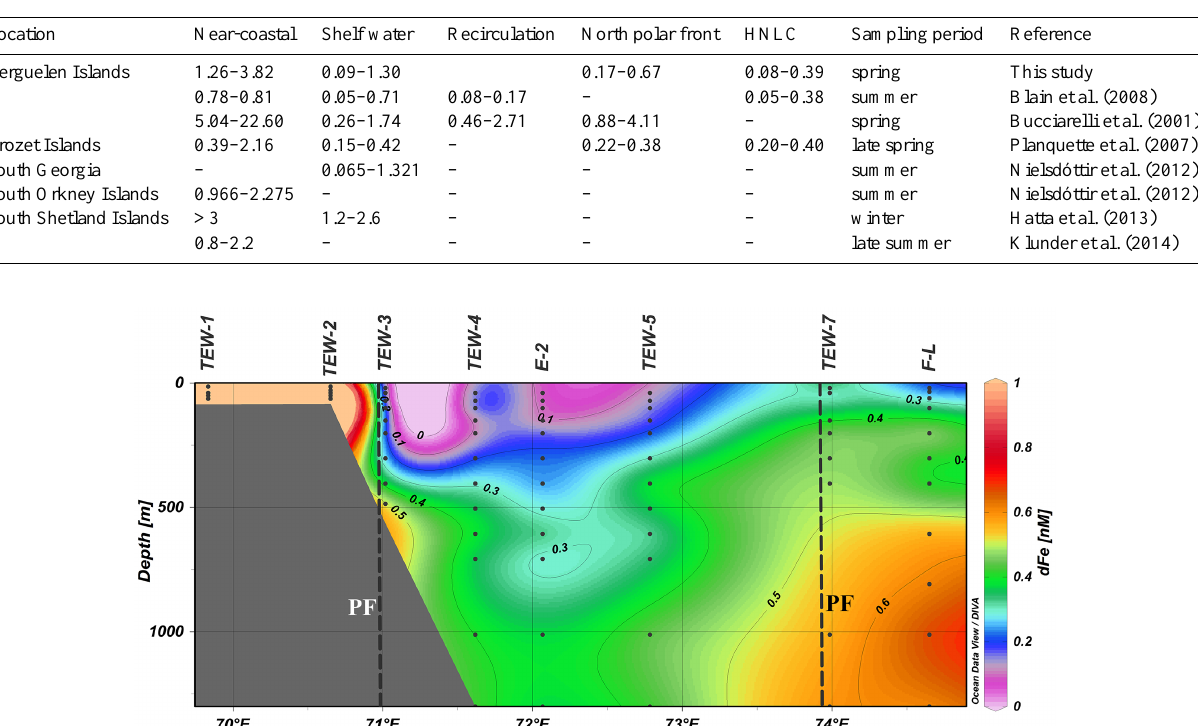
Table 2. Concentrations of dissolved iron (nmolL − 1 ) for various Southern Ocean regions influenced by natural iron fertilisation. Near- coastal and shelf water stations were defined as stations where the bottom depth was less than 100m and between 100 and 600m depth, respectively. Furthermore, near-coastal stations were less than 25 km distant from shore. The recirculation area corresponds to the polar front meander at the north-east of the Kerguelen Islands.